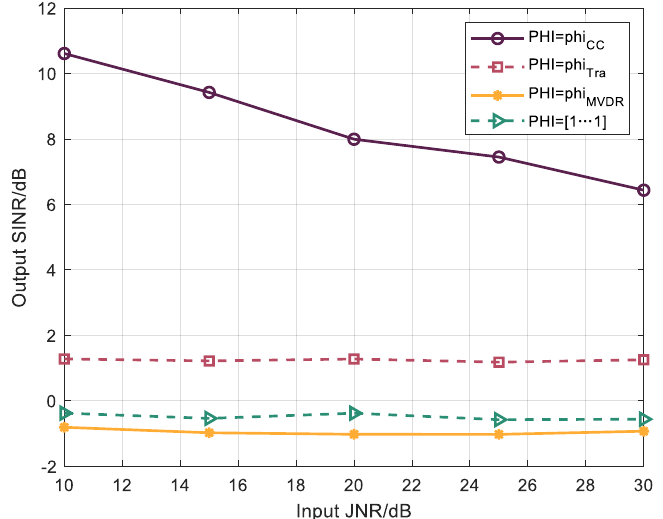
Figure 8. Comparison of small signal anti-jamming performance under strong main lobe jamming.